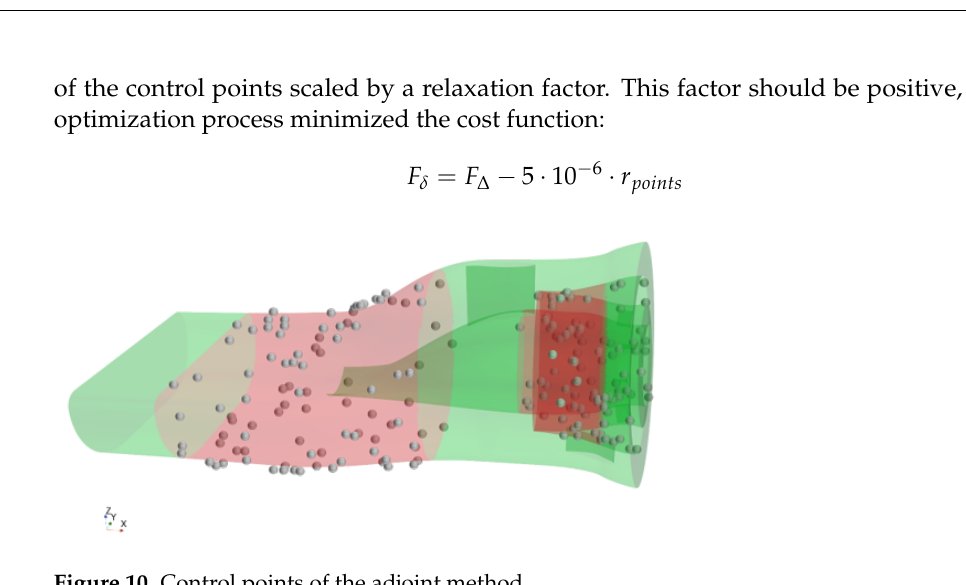
Figure 10. Control points of the adjoint method.